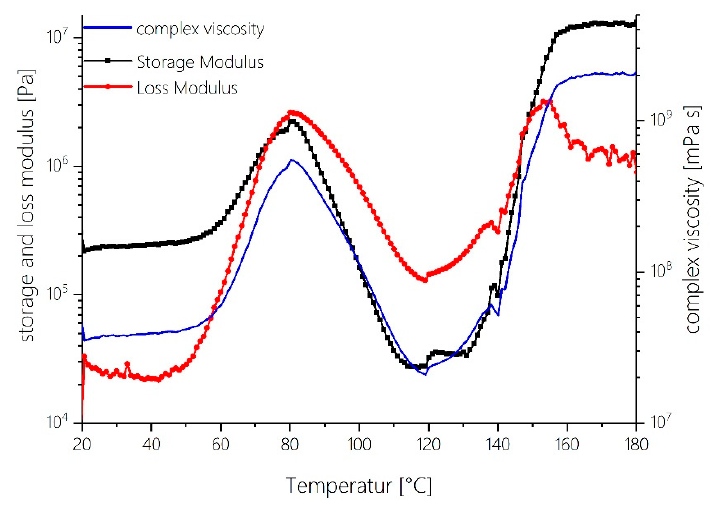
Figure 6 . Changes in viscosity, storage modulus (G ′ ), and loss modulus (G ″ ) and complex viscosity Figure 6. Changes in viscosity, storage modulus (G (cid:48) ), and loss modulus (G”) and complex viscosity | η * | ⏐η * ⏐ during MF resin cure in dependence of temperature as recorded using a plate/plate rheometer during MF resin cure in dependence of temperature as recorded using a plate / plate rheometer setup at setup at a heating rate of 2 °C min − 1 . a heating rate of 2 ◦ C min − 1